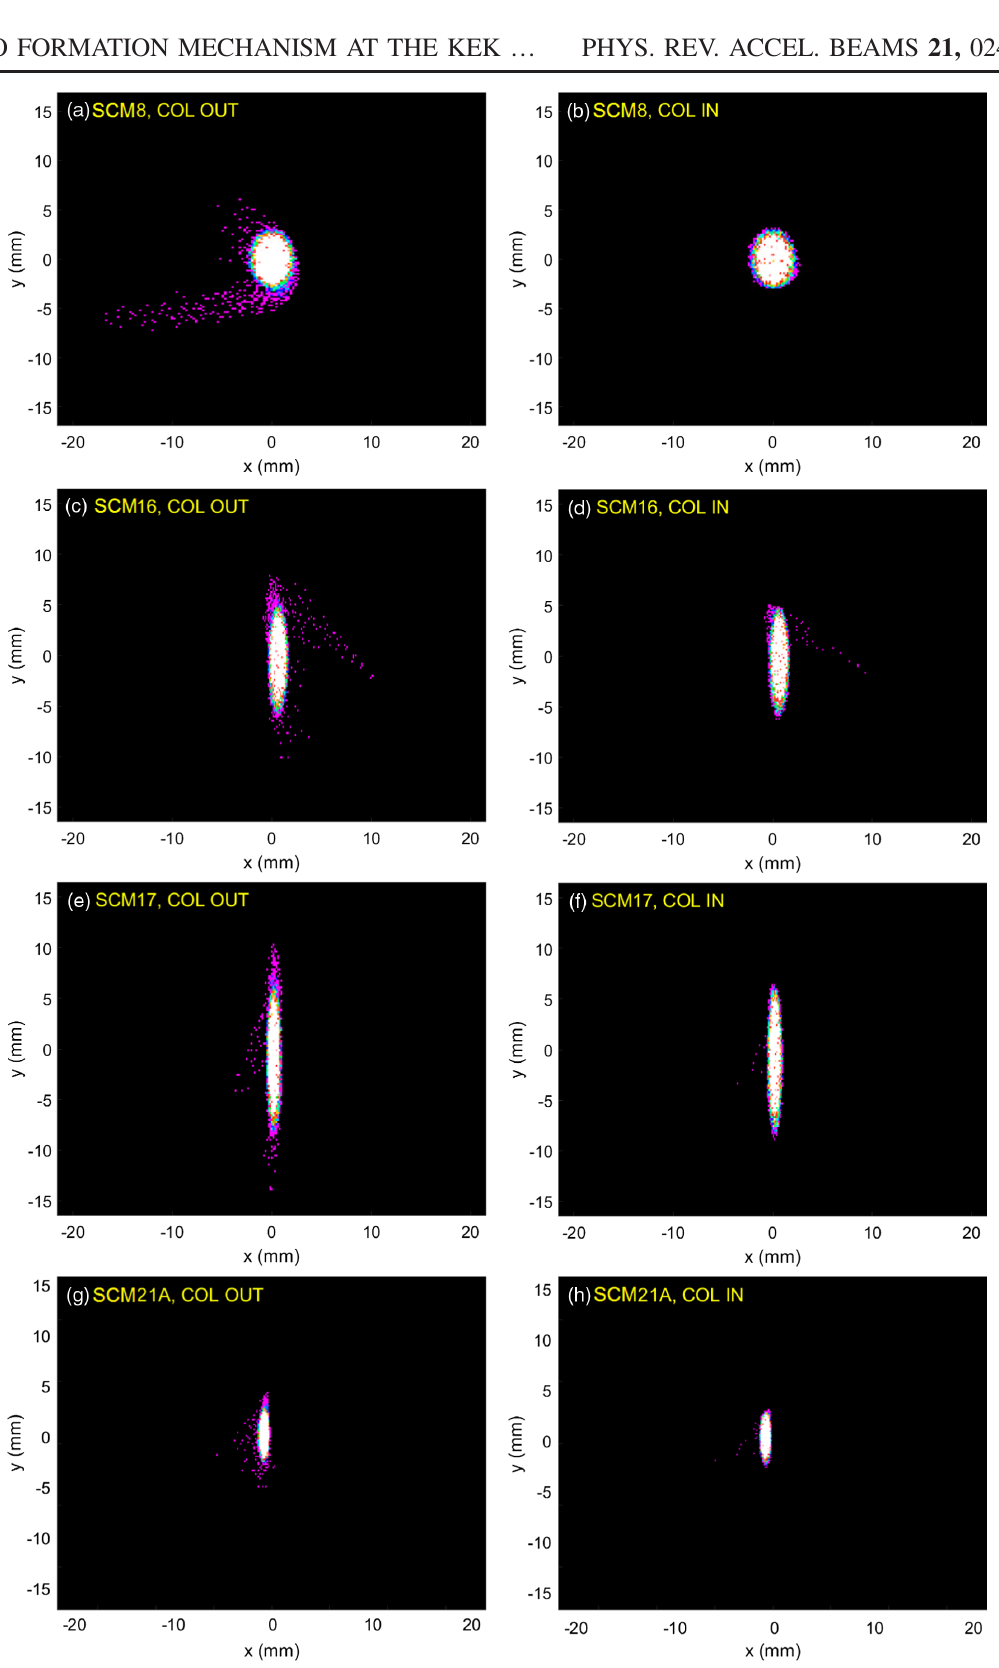
FIG. 23. Simulated beam halo profiles at different screen monitor locations without (left) and with (right) collimation COL1 and COL2, respectively. Tracking was performed for the Gaussian beam with σ ¼ 3 . 3 ps core in the presence of the longitudinal bunch back and forward tails. All the steering coils are turned on, with the horizontal offset of 2.6 mm at the second cavity and the common vertical offset of 2 mm at all three